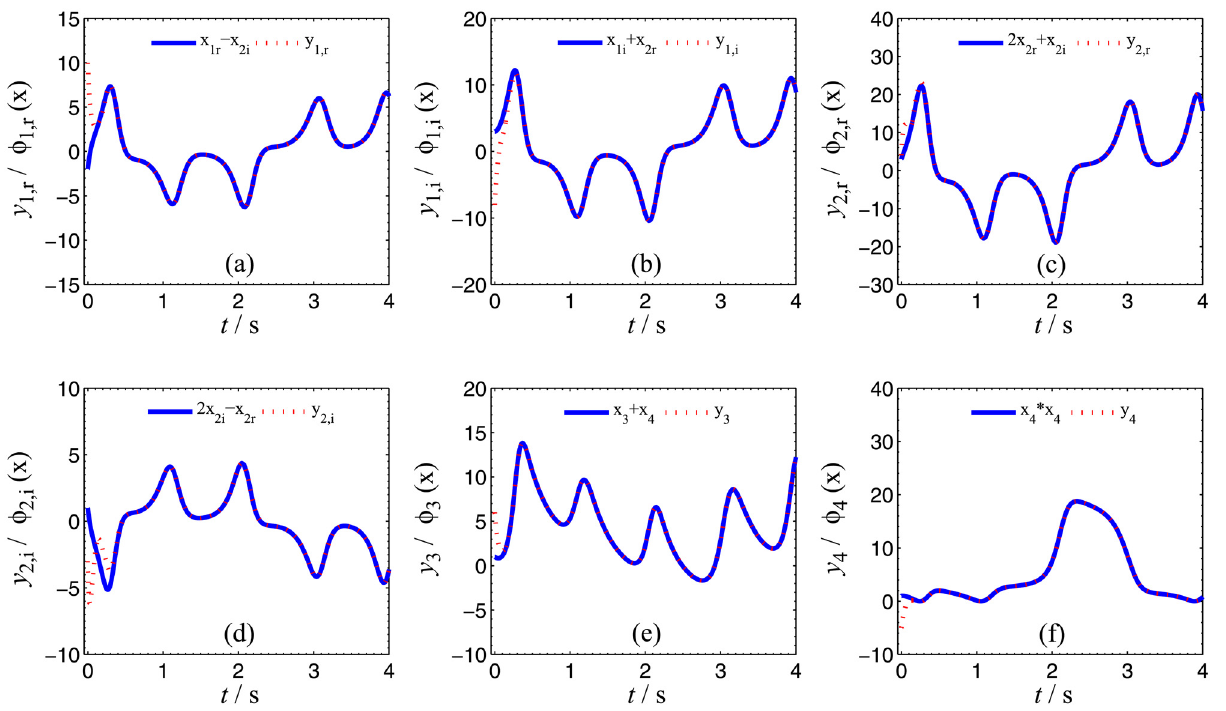
Fig 3. CGS process of systems (12) and (13) with respect to the given complex map vector. (cid:2) ð x Þ ¼ ½ x 1 þ j x 2 ; ð 2 (cid:3) j Þ x 2 ; x 3 þ x 4 ; x 2 4 (cid:4) T . (a) x 1,r − x 2,i , y 1,r ;